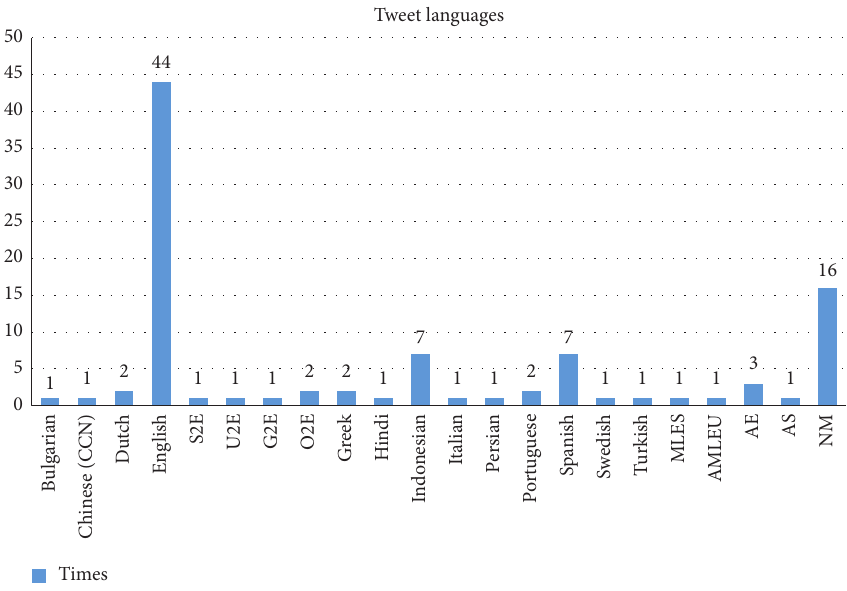
Figure 12: Distribution of languages of collected tweets in reported